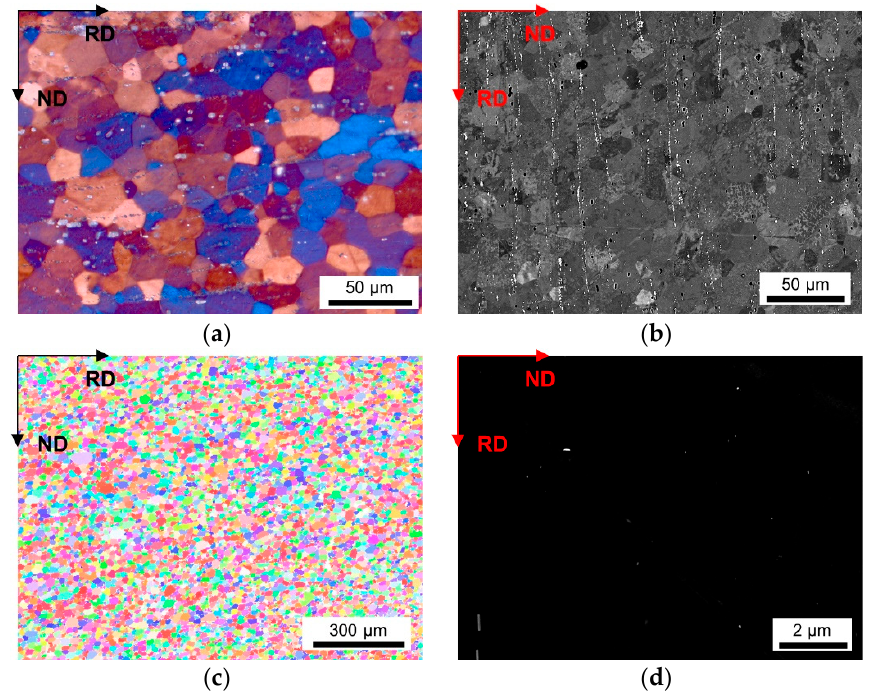
Figure A19. Microstructure of the soft annealed HFe-LMn cast under NR-C conditions, homogenized at 500 °C and cold rolled to a CRD of 63%. ( a ) LOM. ( b ) BSE image. ( c ) EBSD IPF map in RD–ND plane. ( d ) BSE micrograph showing dispersoids.